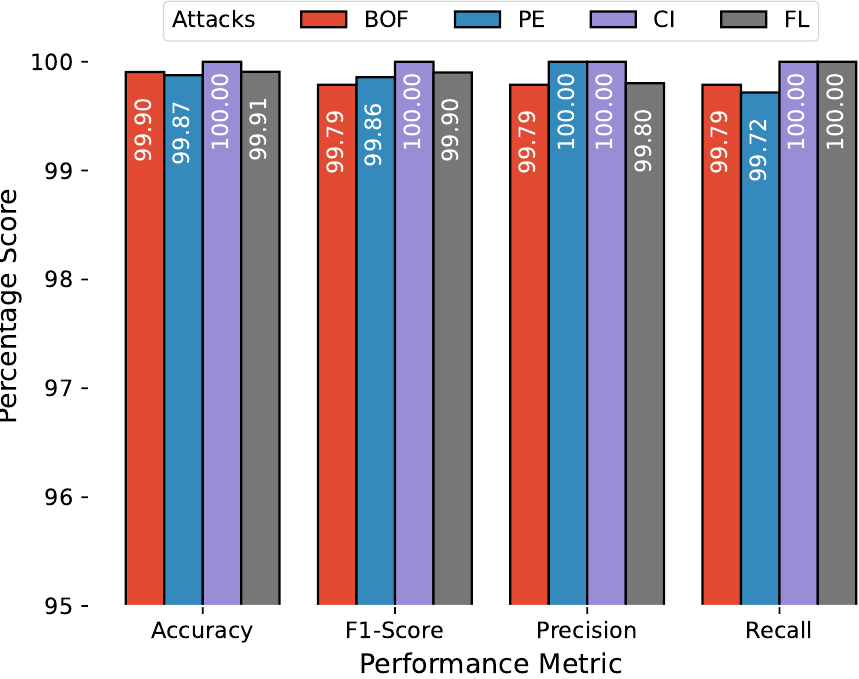
Figure 11. Anomaly detection results of UNM Sendmail dataset, the attack abbreviations are; BF: Buffer overflow, PE: Privilege Escalation, CI: Code Injection, FL: Forwarding